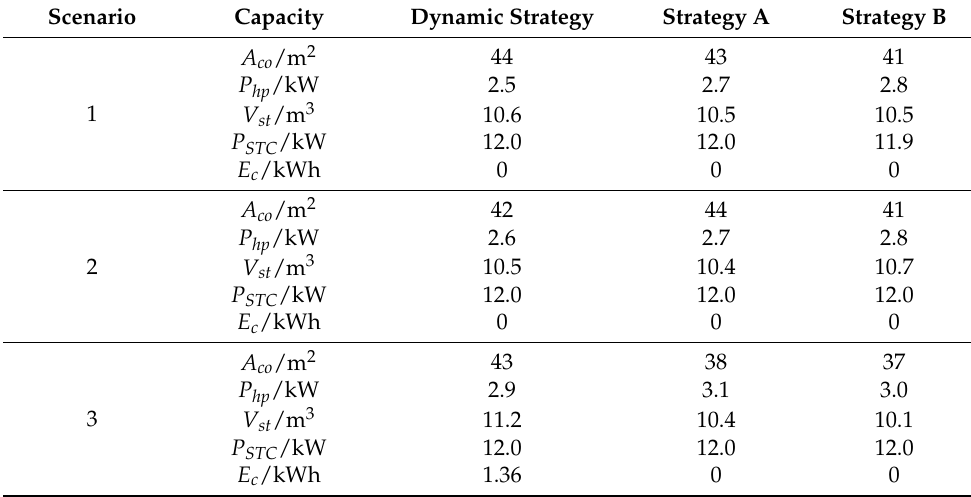
Table 6. Optimal equipment